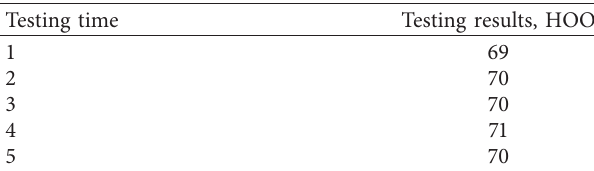
Figure 1: Illustrations of the fluid model without the stent and the wires (a) and with the stent and the wires (b). Table 1: Hardness measurement of the silicon vessel